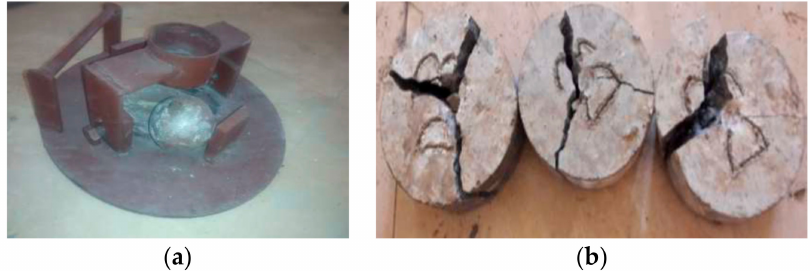
Figure 10. Impact strength Apparatus and specimens. ( a ) base plate and steel ball ( b ) specimen subjected to impact